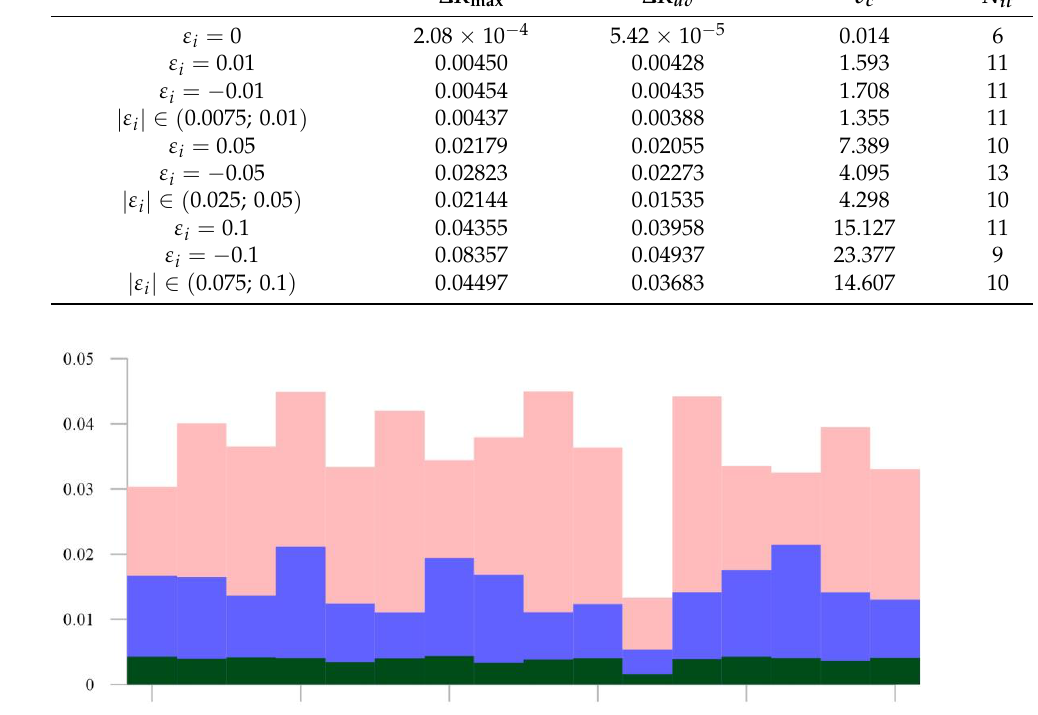
Figure 2. The values Δ𝐾 𝑖 sorted in ascending order 𝑘 𝑖 tr , for random error values: ( 0.075; 0.1